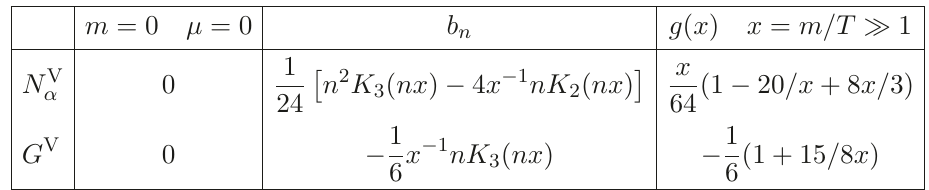
Table 3 . The vector current coefficients (6.3) for an ideal boson field: the first column is the result at m = 0 and µ = 0, the second column is the generic terms of the series expansion (8.4), the third column is the asymptotic expansion for low temperature (8.5).